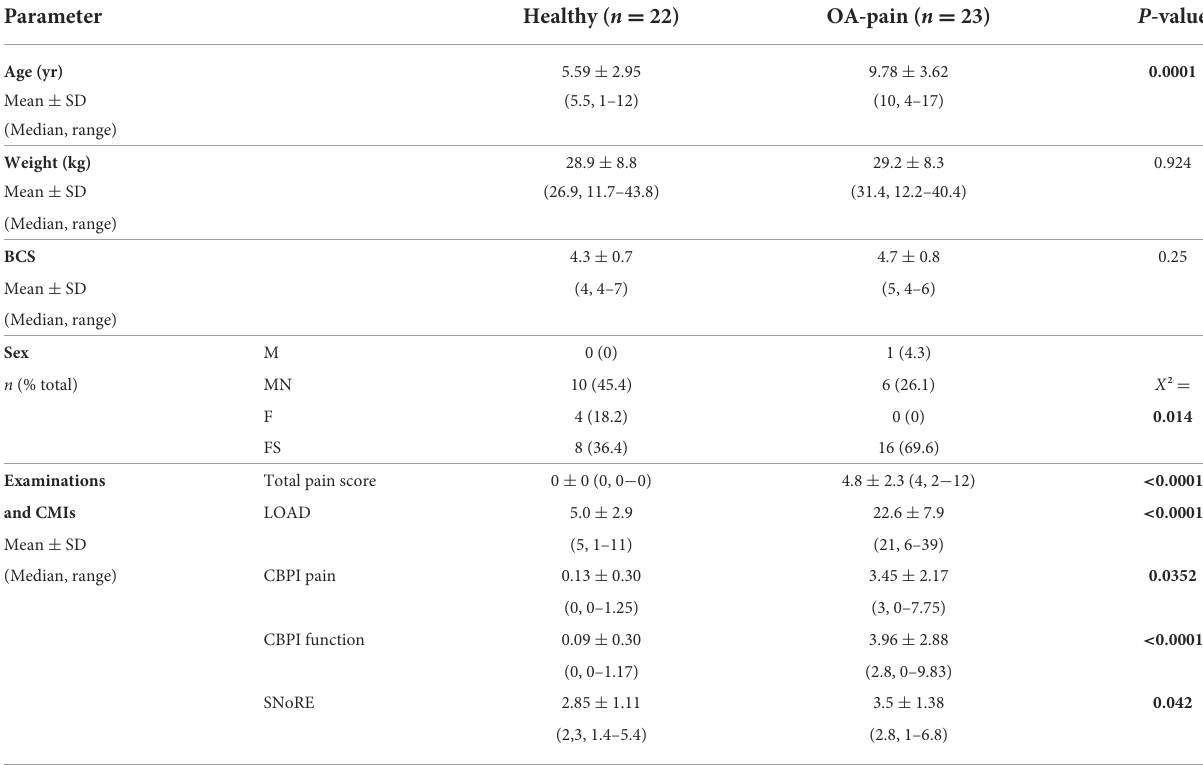
TABLE 1 Demographic information of dogs in the healthy and OA-pain